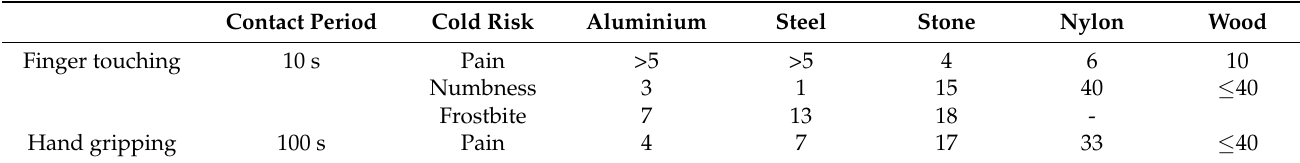
Table 8. Summary of the average T s of various materials in each space in winter. Materials